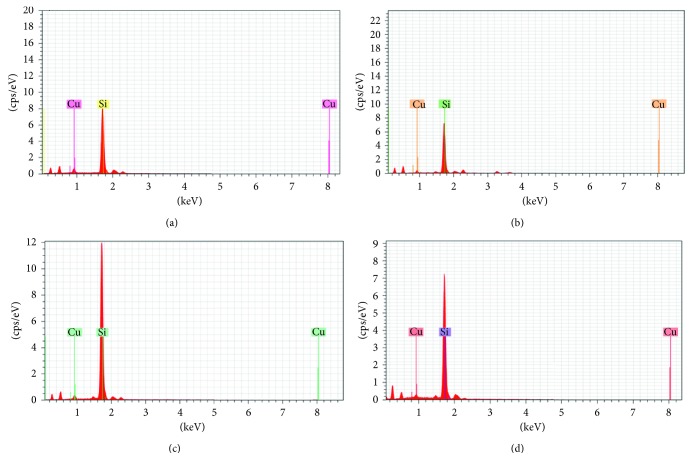
Spot EDS profile of CuNPs synthesized by plant extracts using 10−3 M aqueous CuSO4·5H2O solution in the dark at 100°C: (a) GGFE, (b) GGLE, (c) GGSE, and (d) PZLE.